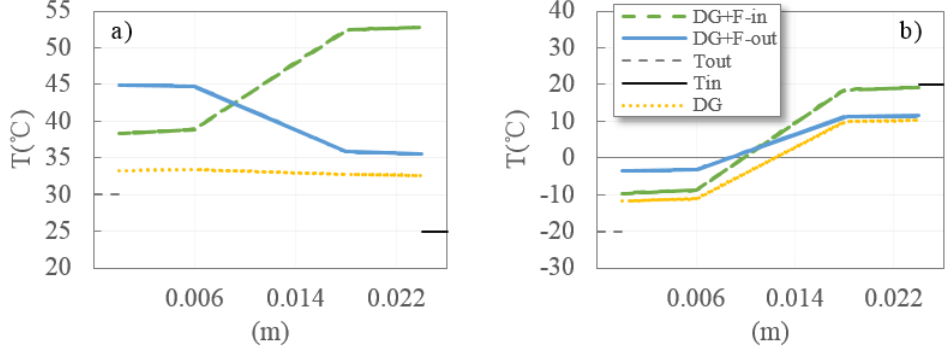
Figure 4. Temperature distribution of DG+F under typical conditions: ( a ) in summer; ( b ) in winter.